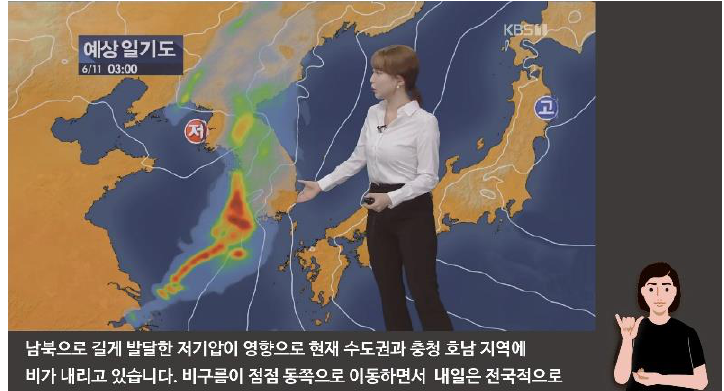
Figure 25. Proposed layout design of information delivery components for weather forecasts.